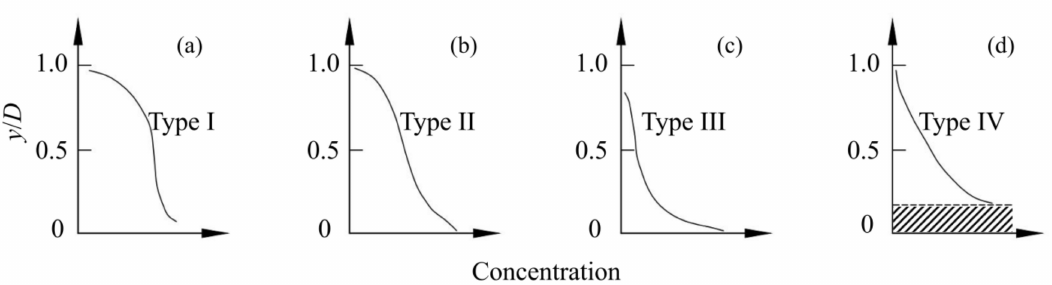
Figure 8. Concentration profiles: ( a ) Type I, homogeneous flow; ( b ) Type II, heterogeneous flow; ( c ) Type III, heterogeneous flow with a sliding bed; and ( d ) Type IV, heterogeneous flow with a sedimentary